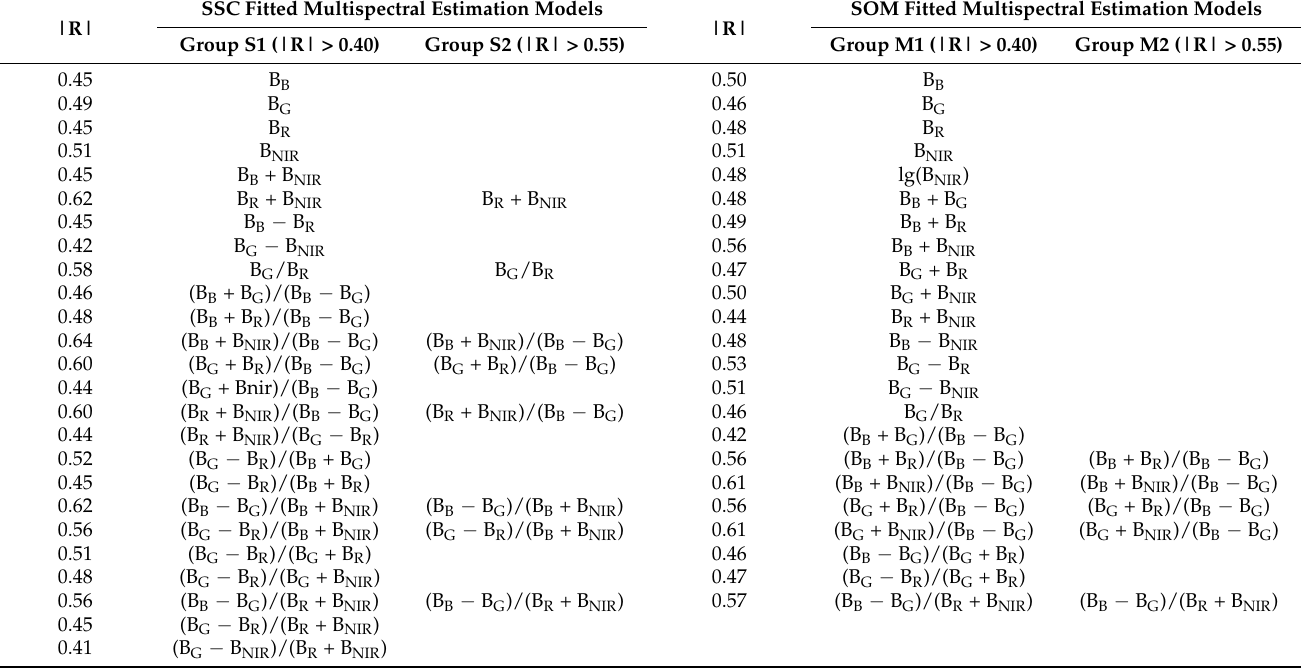
Table 6. Sensitive parameters used to construct the SSC and SOM fitted multispectral estimation